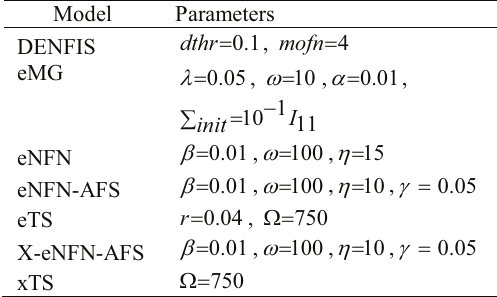
Table 4. Best model parameters: nonlinear